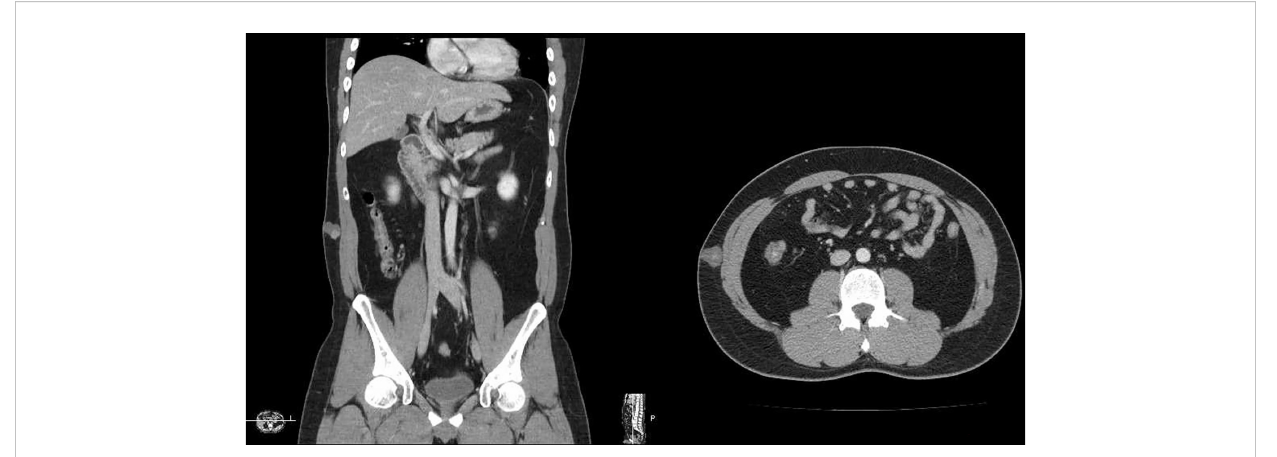
FIGURE 1 A 2.2 cm cystic lesion at the right fl ank isolated in the subcutaneous fat